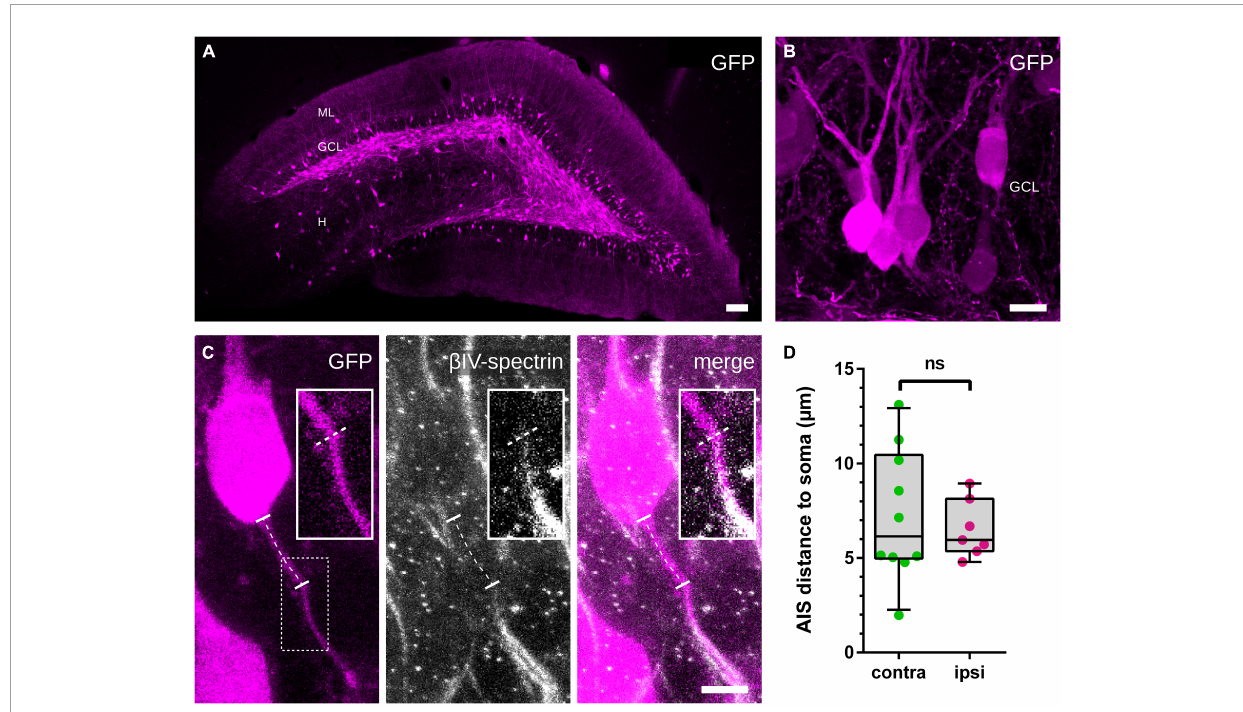
FIGURE3 Distance between soma and AIS. (A,B) An AAV2-hSyn1-GFP was injected into the hilus 14 days prior to HFS and induced a robust GFP expression in GCs, which was used to identify GC somata and originating axons. (C) Colocalization with β IV-spectrin revealed the beginning of the AIS and the path of the axon between the soma and the AIS was traced (indicated by the dotted line). (D) Measured distances revealed no significant differences between the non-stimulated and the stimulated hemispheres. Number of axons: (D) n contralateral = 10, n ipsilateral = 7. Box and whiskers represents 10–90 percentile. ns > 0.05, Mann–Whitney test. Scale bars: (A) 100 µ m, (B) 10 µ m, (C) 5 µ m. GCL, granule cell layer; H, hilus; ML, molecular